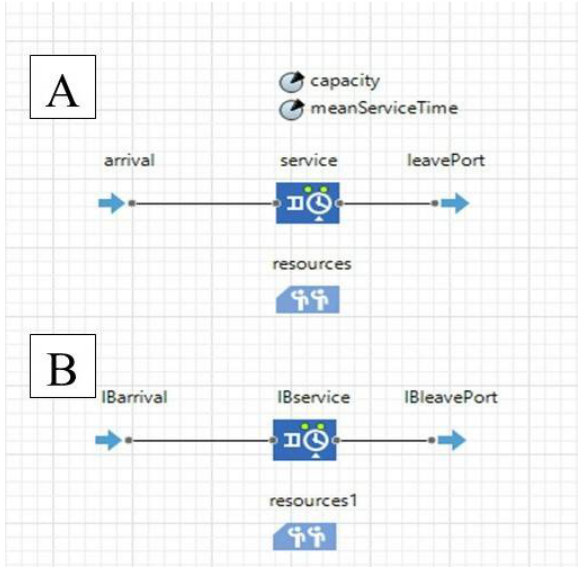
Figure 5. Process flows at ports and waypoints.